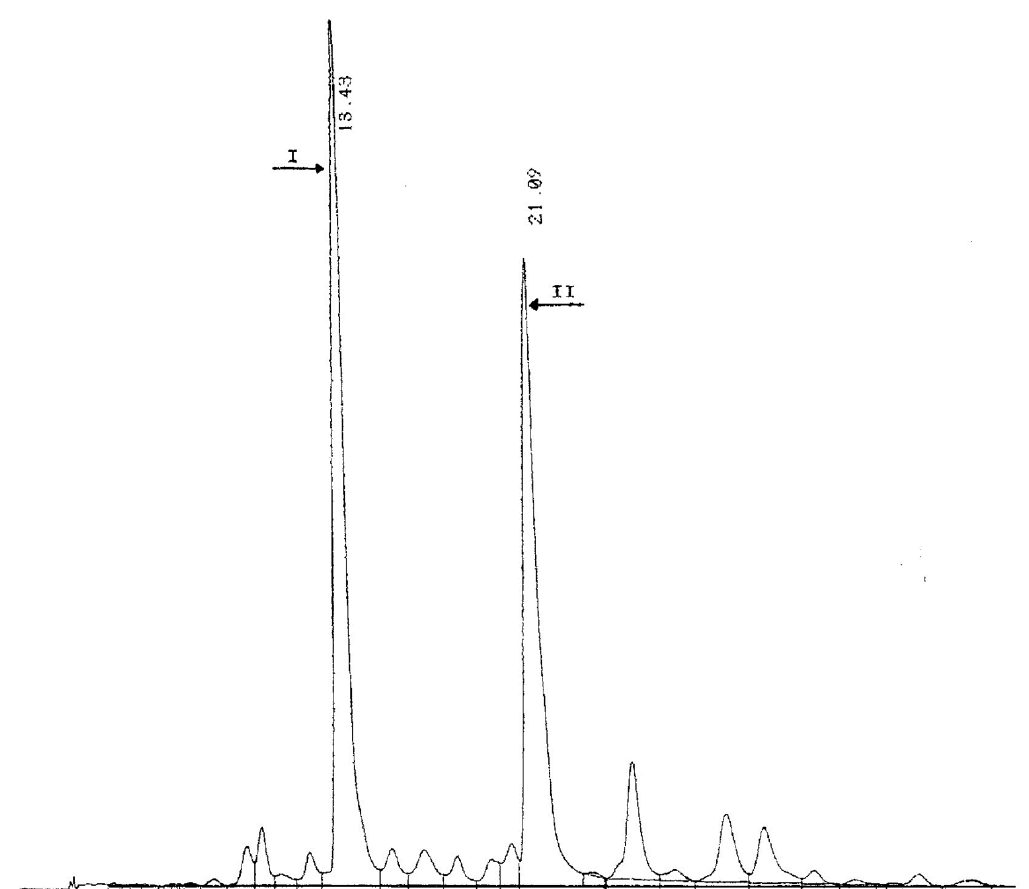
Figure 2. A typical HPLC chromatogram of anthocyanins of blood orange juice (peak I cyanidin-3-glucoide; peak II cyanidin-3-(6 ″ -malonyl)- β -glucoside). Reprinted under CC BY-NC 4.0 from Maccarone et al. [41].